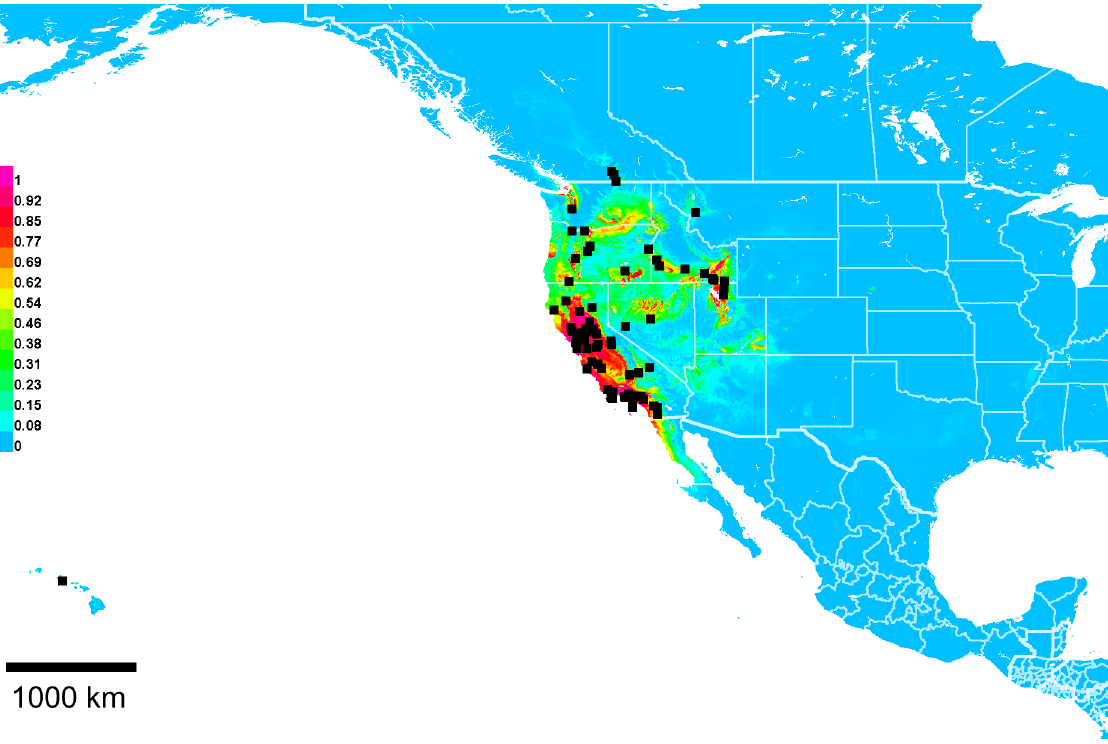
Fig. 32. Georeferenced collection records of Lasioglossum ( D .) helianthi (Cockerell, 1916) (black squares) and predicted distribution by maximum entropy ecological niche modelling in Maxent (colour shading). Warmer colours indicate higher cloglog probability of